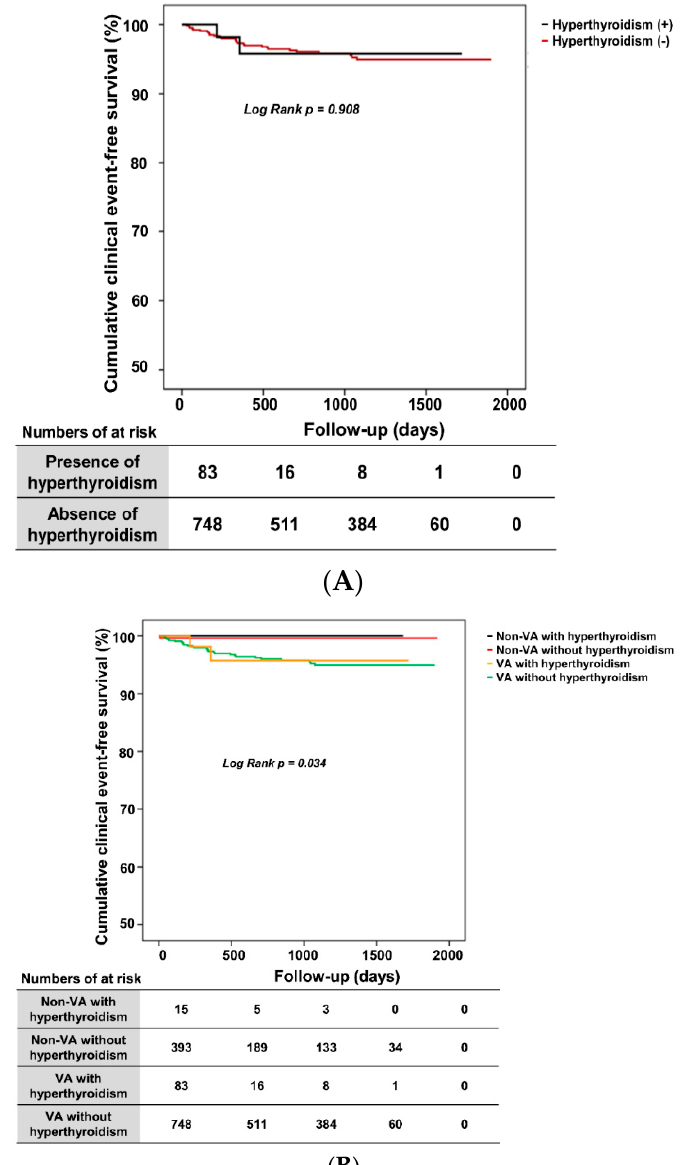
Figure 2. Cumulative composite clinical event-free survival rates according hyperthyroidism status. ( A ) There was no significant difference in cumulative composite clinical event-free survival rate between the VA with hyperthyroidism group and the VA without hyperthyroidism group after long-term follow-up. ( B ) The VA group with hyperthyroidism and the VA group without hyperthyroidism had significantly worse event-free survival after long-term follow-up. VA, vasospastic angina.